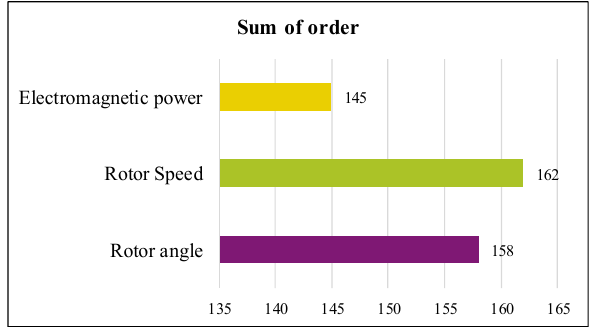
Figure 11. Sum of the order in three types of features.